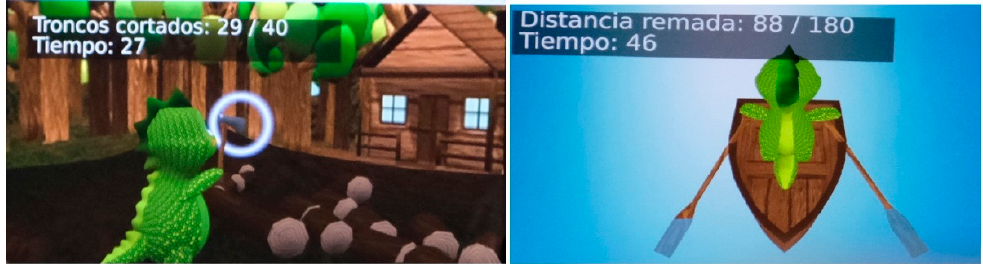
Figure 4. Two different screens of Phiby’s Adventure.